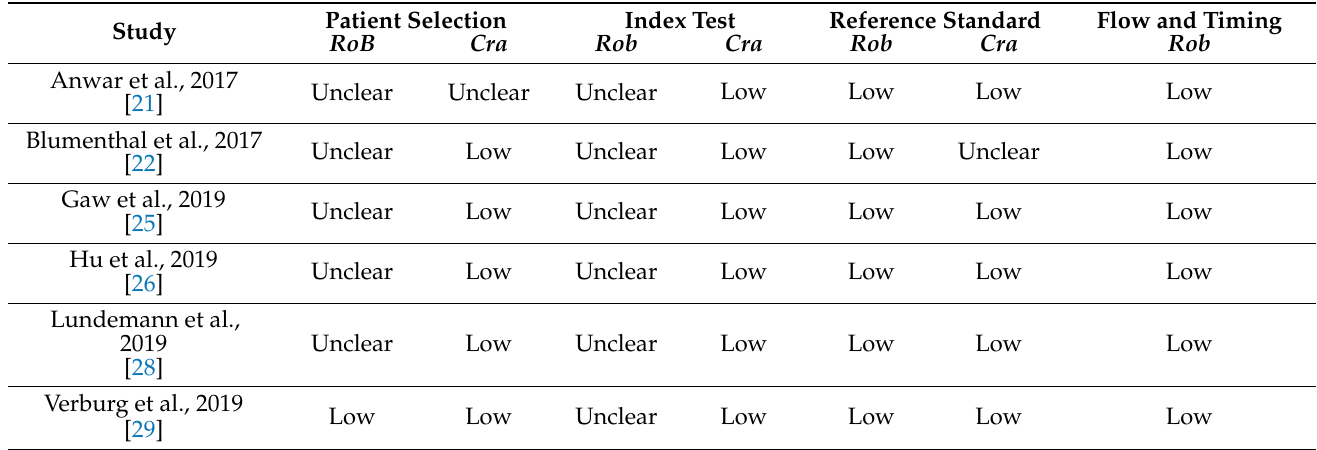
Table 3. QUADAS2. Diagnostic accuracy test by cross-validation.